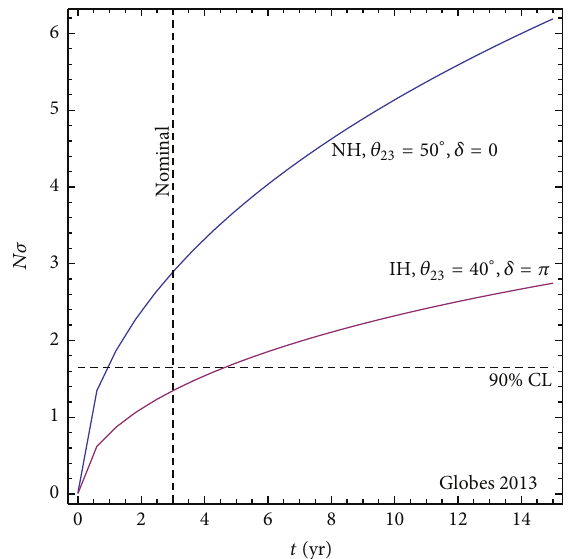
Figure 9: Number of 𝜎 for the hierarchy discovery of a 20-lines PINGU detector as a function of time for two extreme cases of the true parameter values (figure from